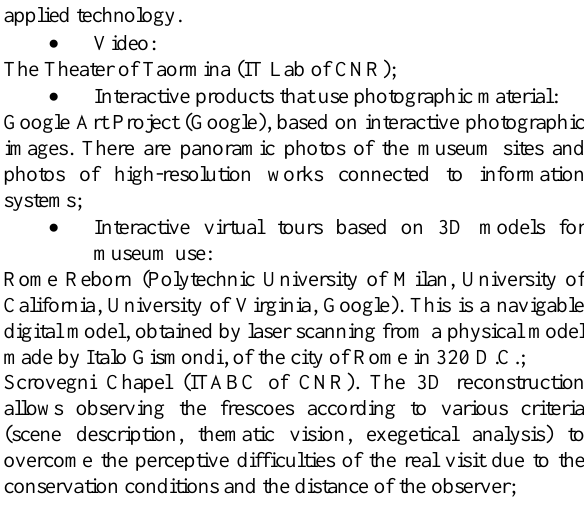
Figure 1: Cloud of point from laser scanning